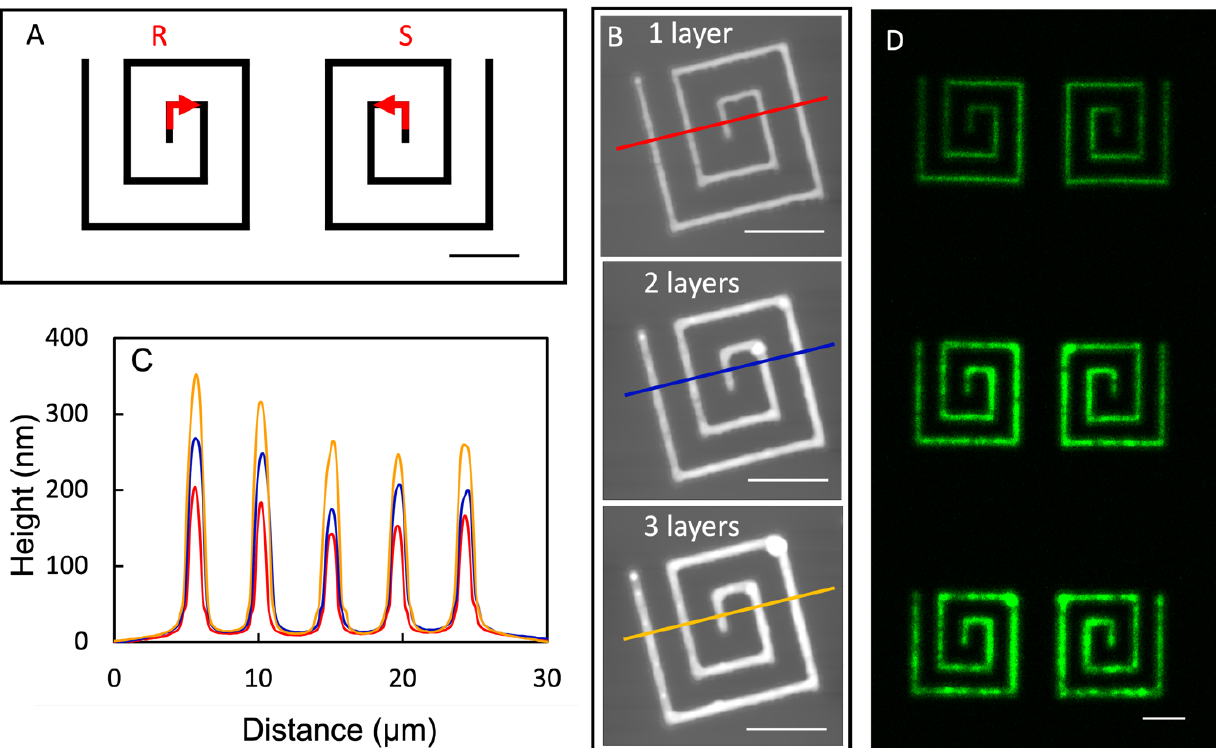
Figure 6. ( A ) A schematic diagram of the designed pair of R and S square spirals. ( B ) Topographic AFM images of the chiral POPC structures following the design of the R-structure in ( A ) with increasing height from top to bottom: 1, 2, and 3 passes, respectively. ( C ) Three cursor profiles indicated in ( B ). ( D ) Laser scanning confocal images acquired 10 days after the delivery for the structures shown in ( B ) (left) and their counterpart S-structures (right). All scale bars = 10 µm.